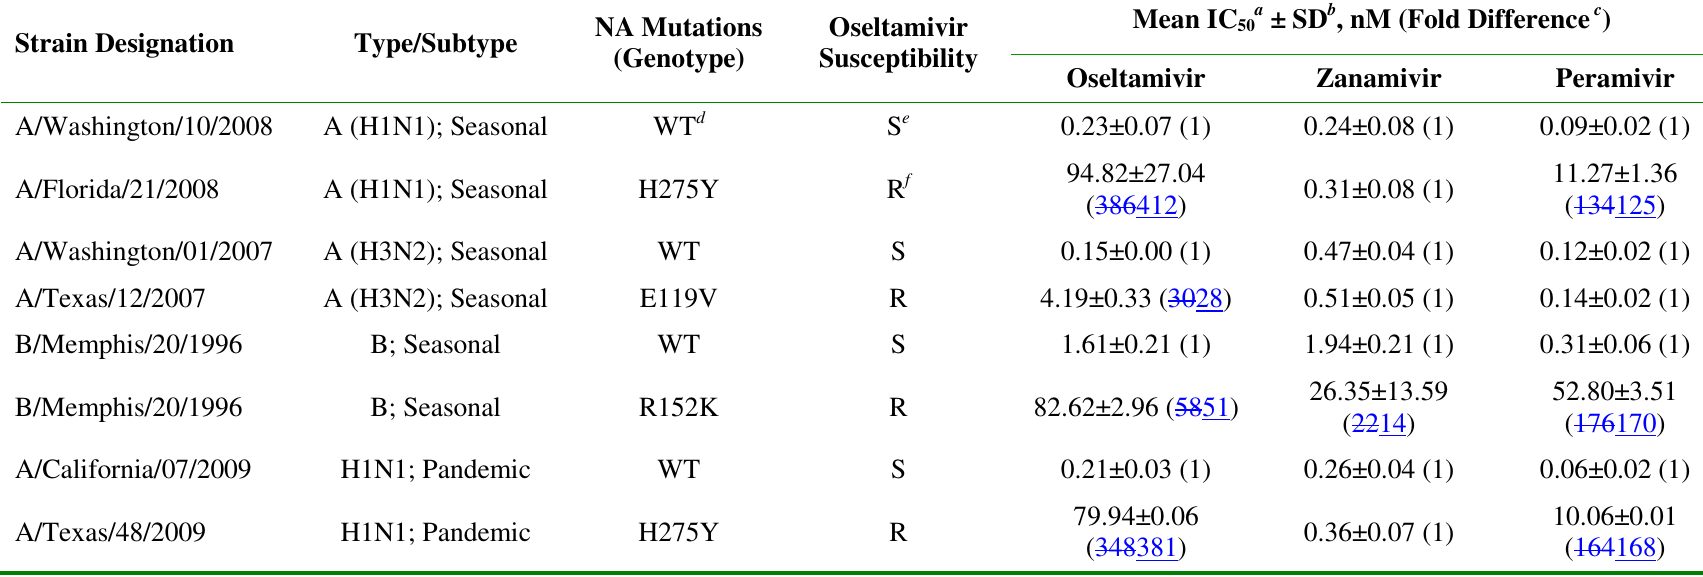
Table 1. Reference viruses used as controls in the chemiluminescent NI